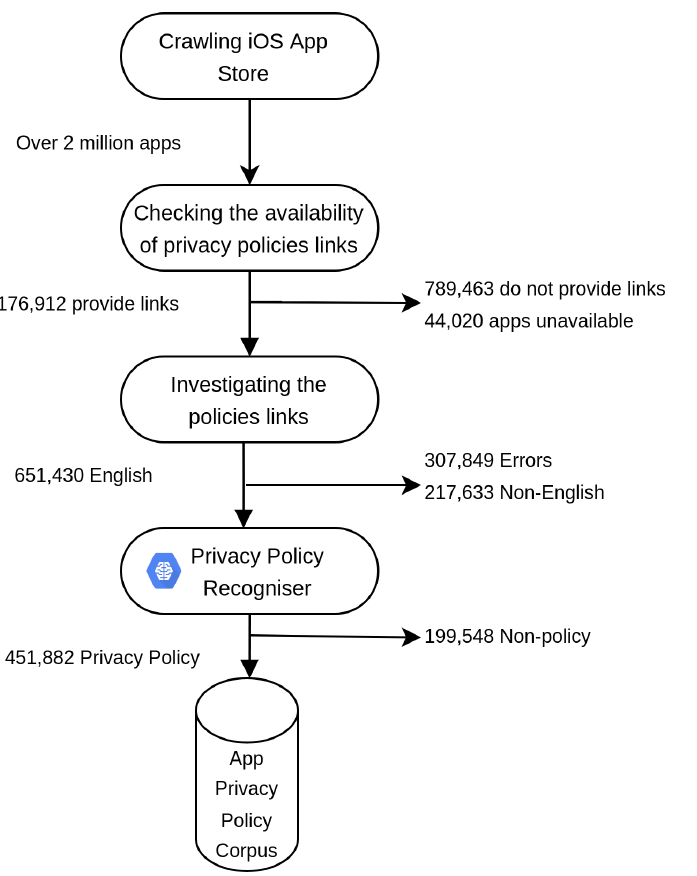
Figure 2. Processing pipeline of the App Privacy Policy